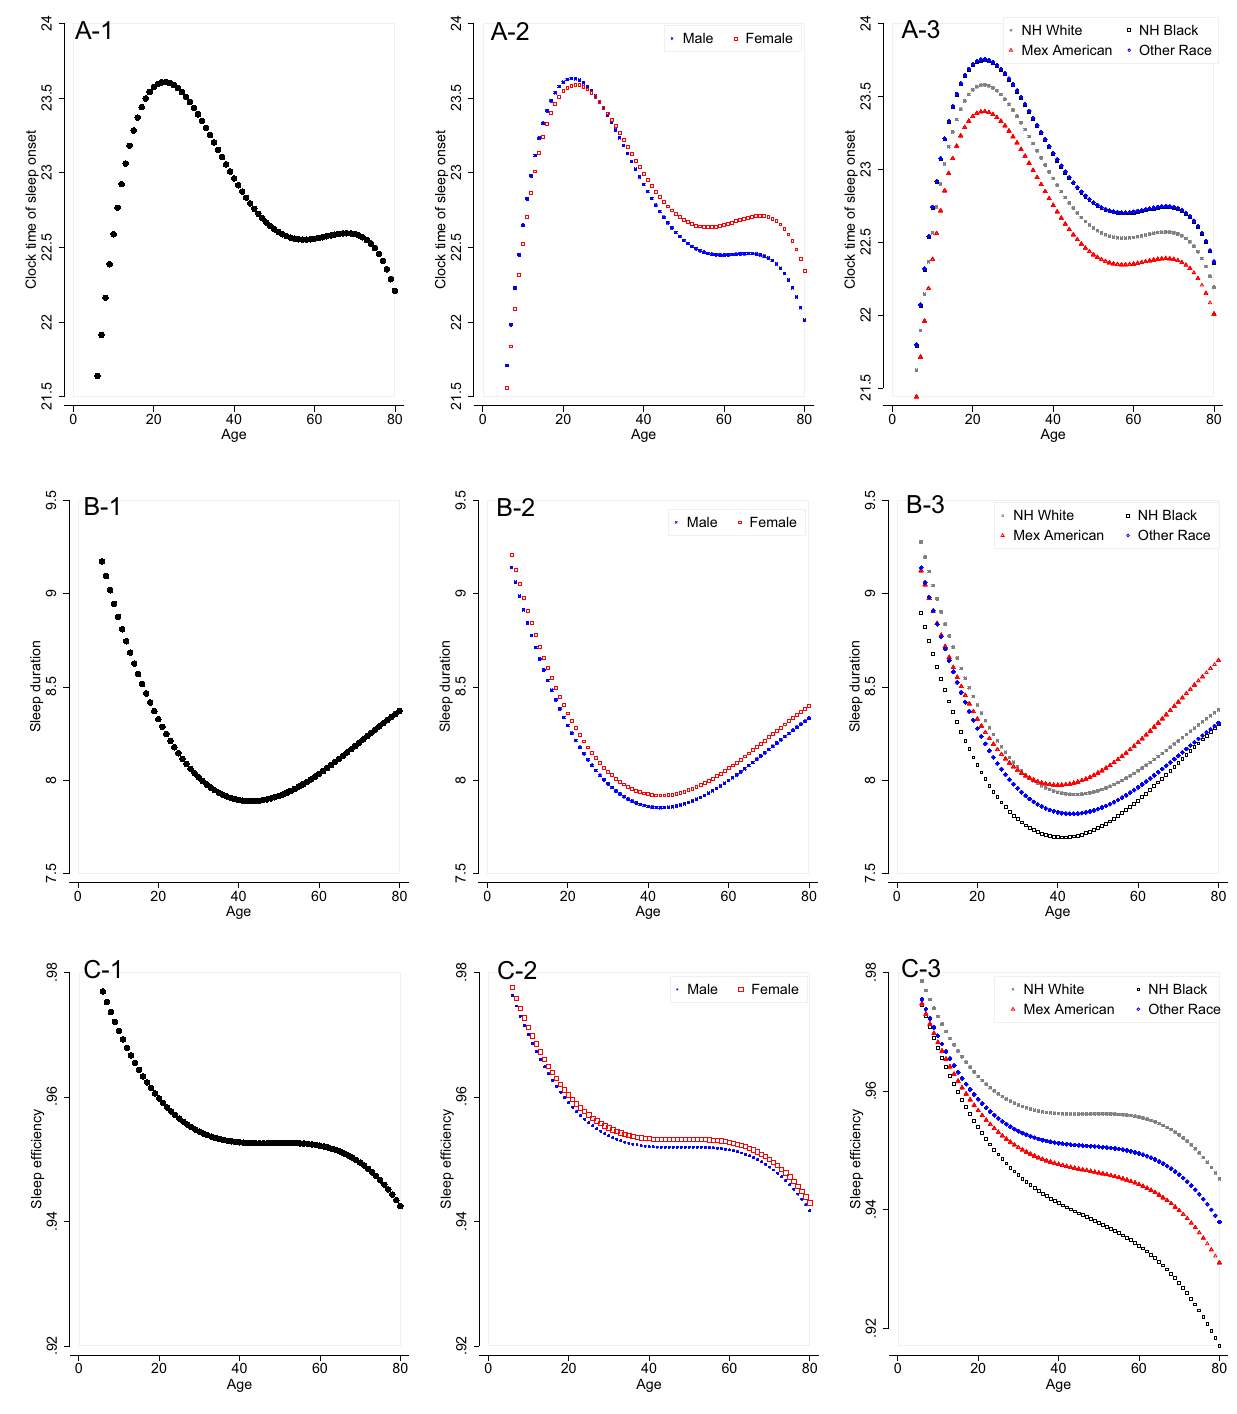
Figure 2. Age, sex and race distribution of clock time of sleep onset (CTSO), sleep duration and sleep efficiency. ( A ) 1–3 for CTSO. Please note that the curve for Other Race is overlapped with the curve of NH Blacks; ( B ) 1–3 for sleep duration and ( C ) 1–3 for sleep